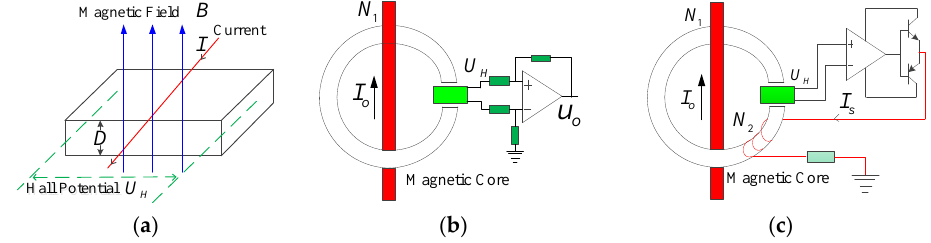
Figure 2. ( a ) Schematic diagram of the Hall-effect; ( b ) Schematic diagram of direct measurement by the Hall current sensor; ( c ) Schematic diagram of the zero-flux Hall current sensor.